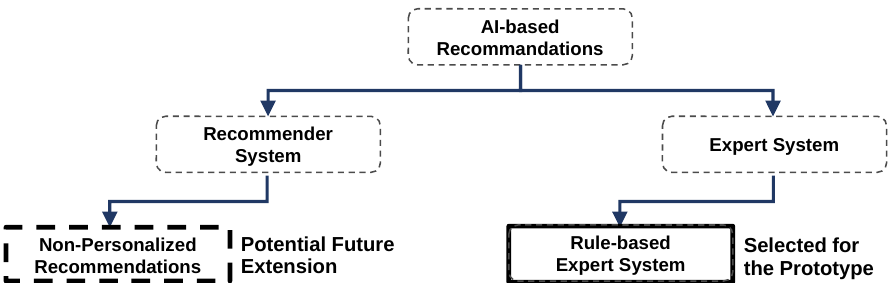
Figure 8. Categorization of the selected approach in the recommendation system